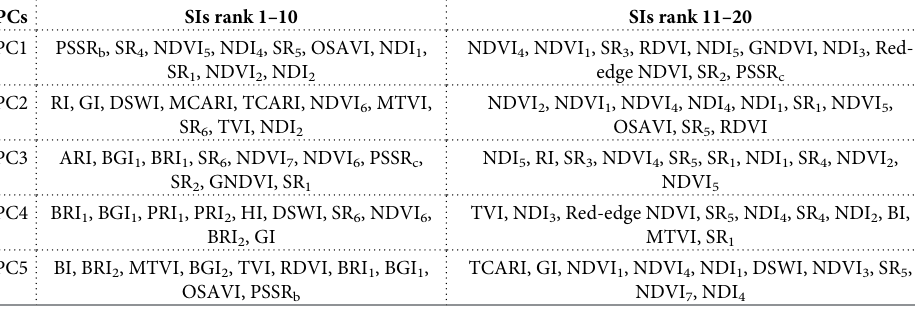
Table 3. Five PCs and their component SIs ranking from 1 to